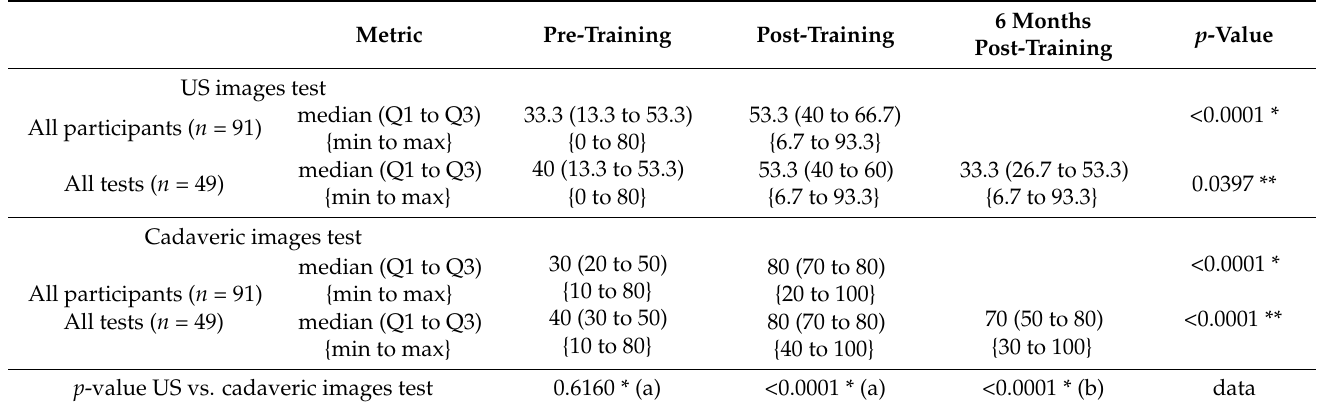
Table 1. Summary of cardiovascular anatomy test results of cadaveric and US images on the inter- vention group.